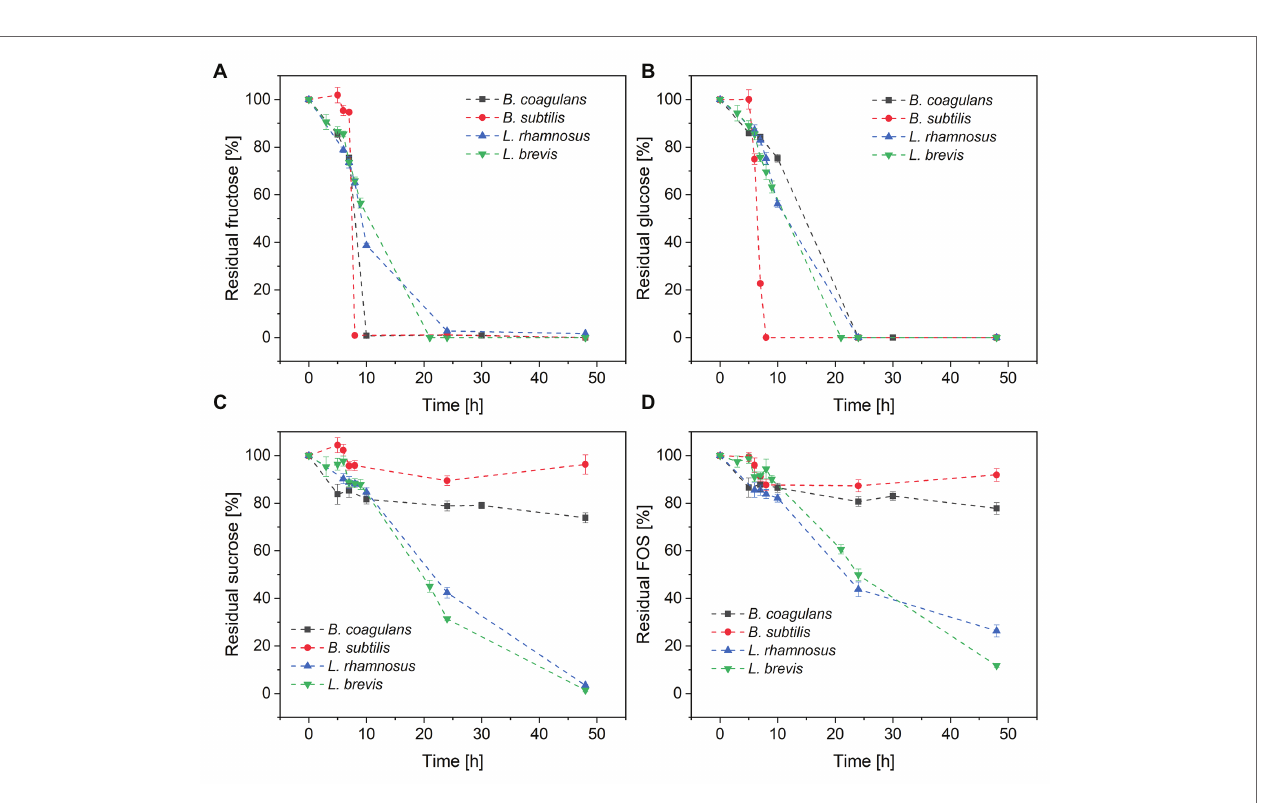
FIGURE 3 | Metabolism of the sugar components in crude FOS by probiotic bacteria during a fermentation lasting 48 h: (A) fructose (B) glucose (C) sucrose, and (D) FOS. T = 40 ° C, pH = 6.8, and aeration = 0.5 vvm. Values are means ± error ( n =